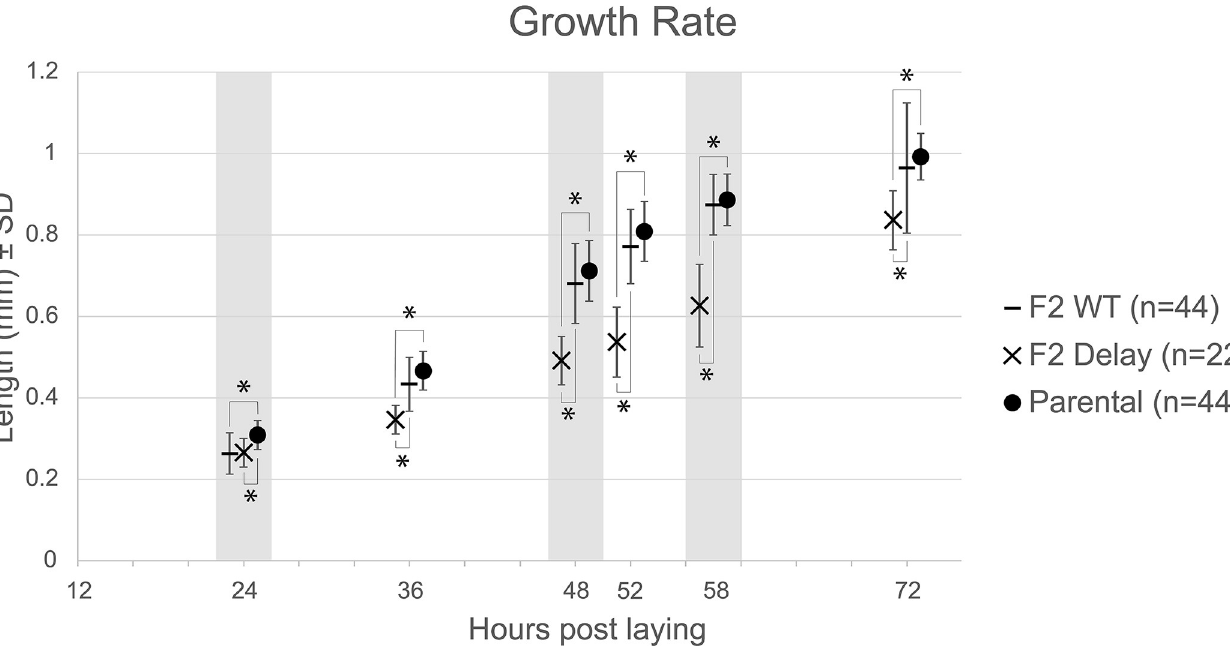
Fig 2. Development of F2 hybrids. Nematode total length is plotted against the number of hours elapsed after each embryo was deposited by a hermaphrodite onto an NGM agar plate. The average length of delayed F2 nematodes is plotted as an X; the average length of wild-type F2 siblings is plotted as a dash (horizontal line). The average length of the combination of the AF16 and HK104 parental isolates is plotted as a circle. Vertical lines depict one standard deviation. Alternating background shading is used to distinguish data collected at 24, 36, 48, 52, 58, and 72 hours post laying, at which point every individual had reached adulthood. The data series at each timepoint have been jittered on the x-axis for clarity. Statistical analyses were conducted to identify significant differences between the parental and F2 wild-type populations, the parental and F2 delayed populations, and the F2 wild-type and delayed populations. Brackets indicate statistically different comparisons (Bonferroni-corrected Student’s T-tests, alpha 0.05; see Table 1 for p-values).